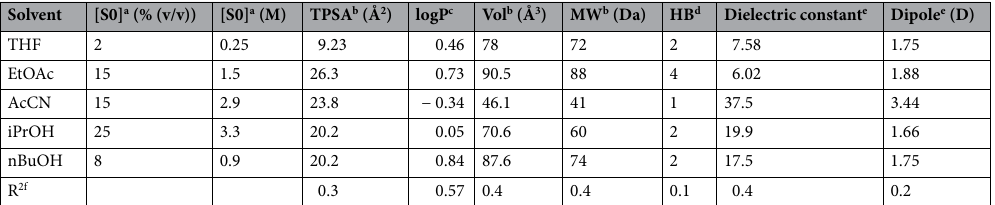
Table 1. Correlation of holo-TK inactivation to physicochemical properties of the polar organic solvents. a Concentration of solvent required for complete [S b Calculated using the Molinsky 0 ] inactivation of holo-TK. online software tool (http:// www. molin spira tion. com). c Experimental values from Sangster 77 . d Number of potential hydrogen bond acceptor and donor sites. e Obtained from the Louisiana State University Macromolecular Studies Group Server (http:// macro. lsu. edu/). f R 2 values are for linear Pearson correlations to [S 0 ] in Molar.